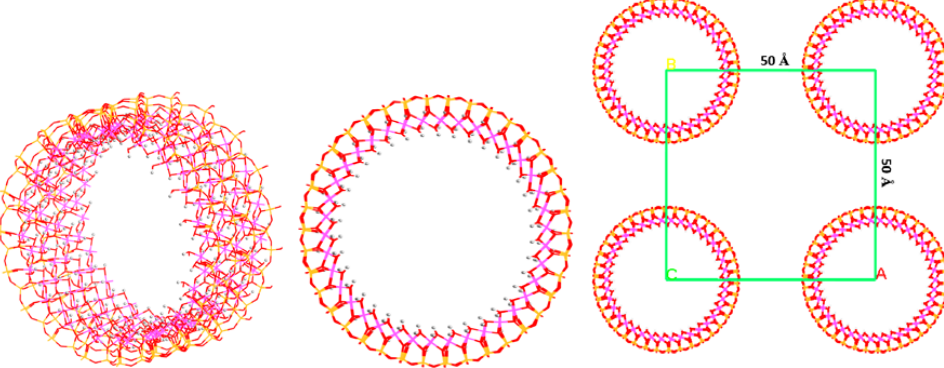
Figure 1. Structure of the 1 × 1 × 2 halloysite supercell with chirality (19,0) optimized. The Si, Al, O, and H atoms are in yellow, pink, red, and light-gray colors. These color patterns are maintained in the rest of the figures of this work.